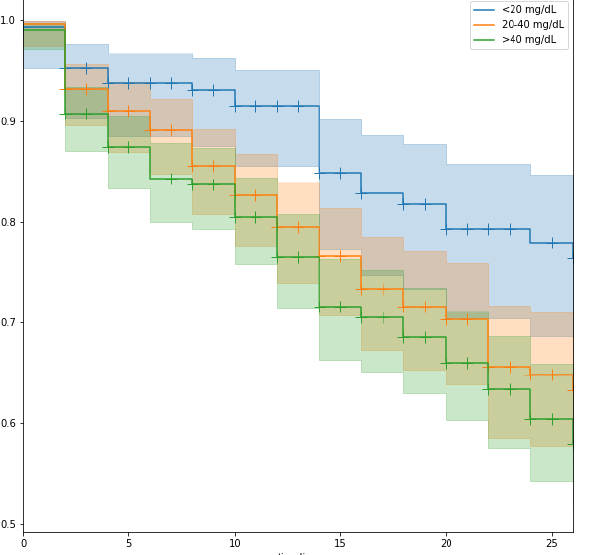
Fig. 4. Kaplan-Meier curves for 28 days all cause mortality of Czech patients according admission estimated GFR (MDRD). group comparison by log-rank test, P